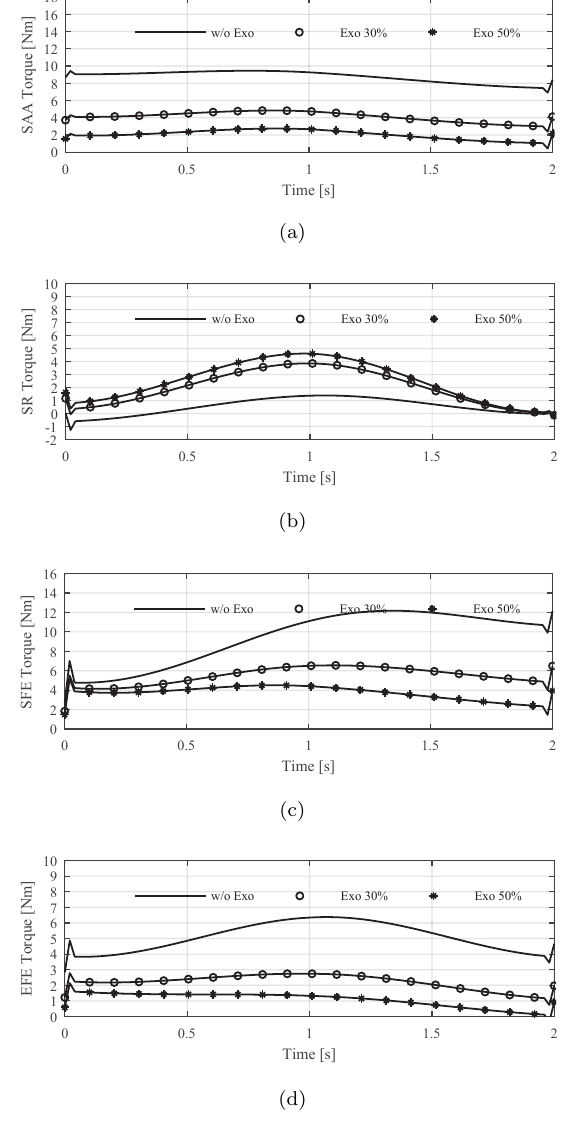
Figure 12: Equivalent joint torques in the human mus- culoskeletal system during the overhead reach, (a) shoulder abduction/adduction, (b) shoulder internal/external rotation, (c) shoulder flexion/extension, (d) elbow flex- ion/extension assistance of the overhead reach. The MMA of the muscles in the arm is shown in Fig. 13. The MMA is reduced with the aid of the ex- oskeleton for both the low-level and high-level assis- tance. The mean MMA during the simulations, listed in Table 5, is reduced with 45% in the low-level assis- tance and 62% for the high-level assistance. The human energy consumption for the three